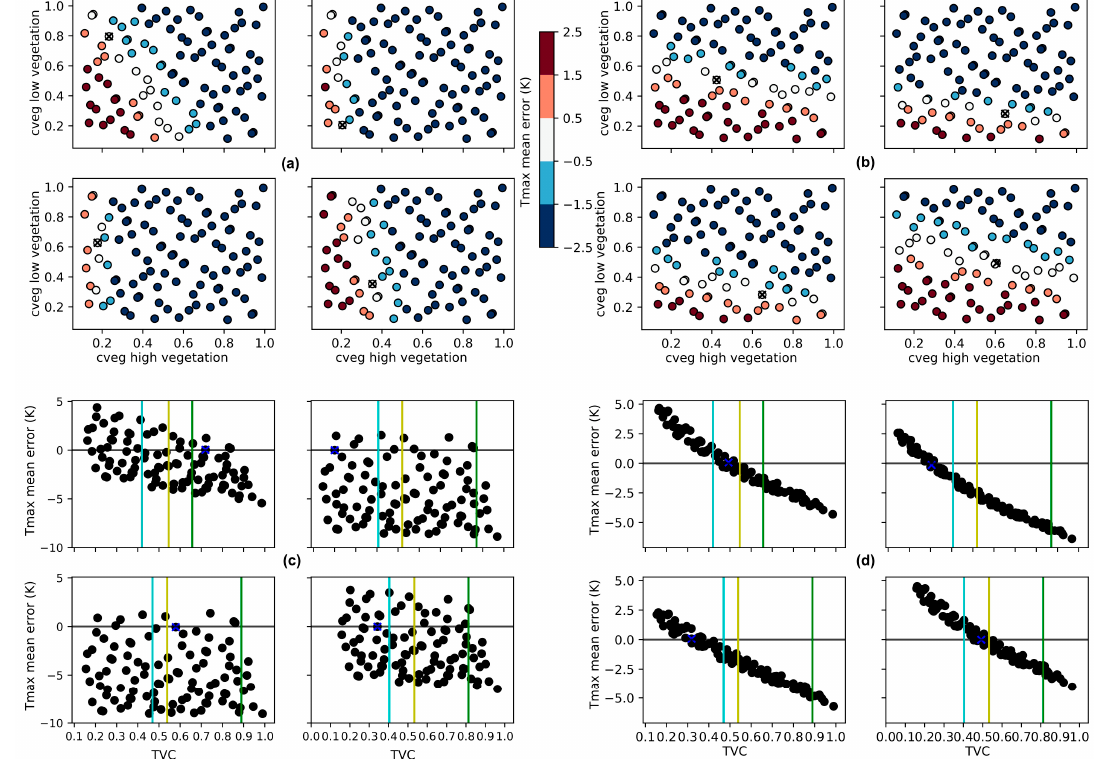
Figure 10. Vegetation density (cveg) 100 perturbation pairs (high vegetation x-axis, low vegetation y-axis) and associated Tmax mean error (K) of the ( a ) original and ( b ) revised vegetation cover using ESA-CCI. The cross marks the best pair (with Tmax bias closer to zero). Scatterplots of the Tmax mean error (y-axis; K) as function of the total vegetation cover (TVC) (x-axis) of the 100 perturbations: with the ( c ) original and ( d ) revised vegetation cover using CCI. The blue cross marks the best perturbation (with Tmax Mean Error closer to zero). The vertical lines indicate the TVC in control (green), reviser (yellow) and CGLS-Fcover (cyan). The 4 sub-panels in each panel denote the 4 grid-points in the domain (top left) North West, (top right) North East, (bottom left) South West (bottom right) South East (see Figure S1), sharing the same vertical and horizontal